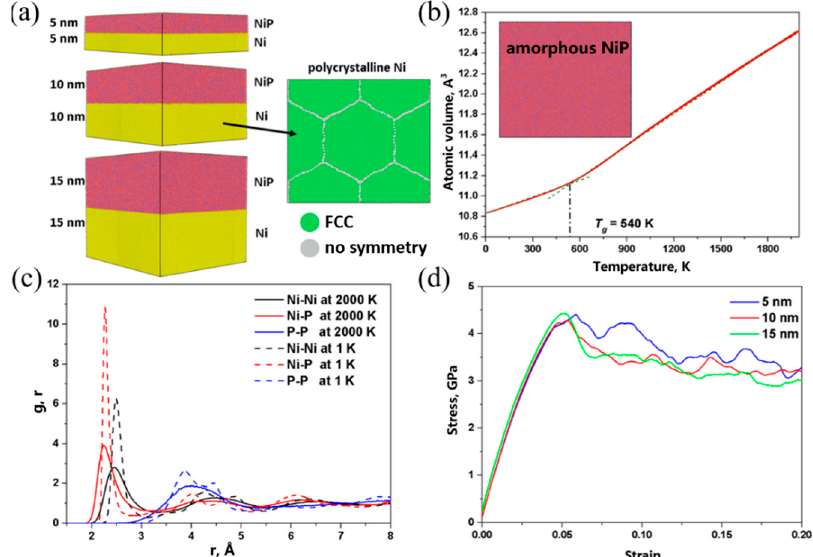
Figure 7. ( a ) NiP/Ni composite models with different layer thicknesses; ( b ) Atomic volume versus temperature curve. The glass transition temperature T g is denoted; ( c ) Evolution of pair-distribution functions during cooling; ( d ) Tensile stress–strain curves of the 5, 10, and 15 nm NiP/Ni composite models.